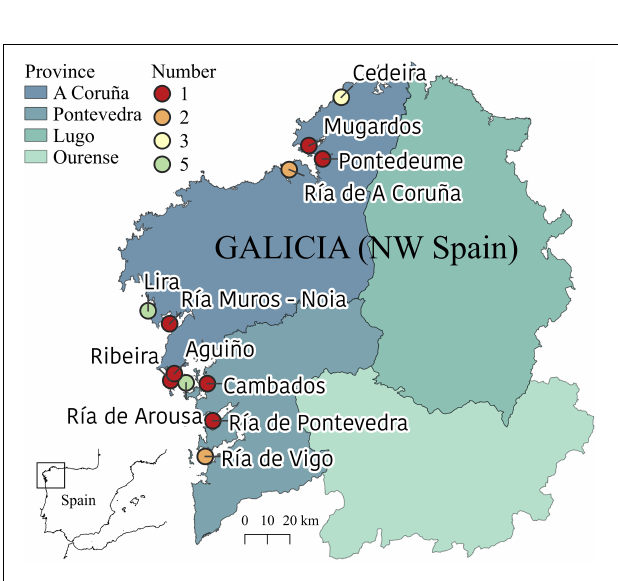
FIGURE 5 | Local scale study sites ( n = 17) in Galicia by province (A Coruña and Pontevedra) and number of publications analyzed (1–5).